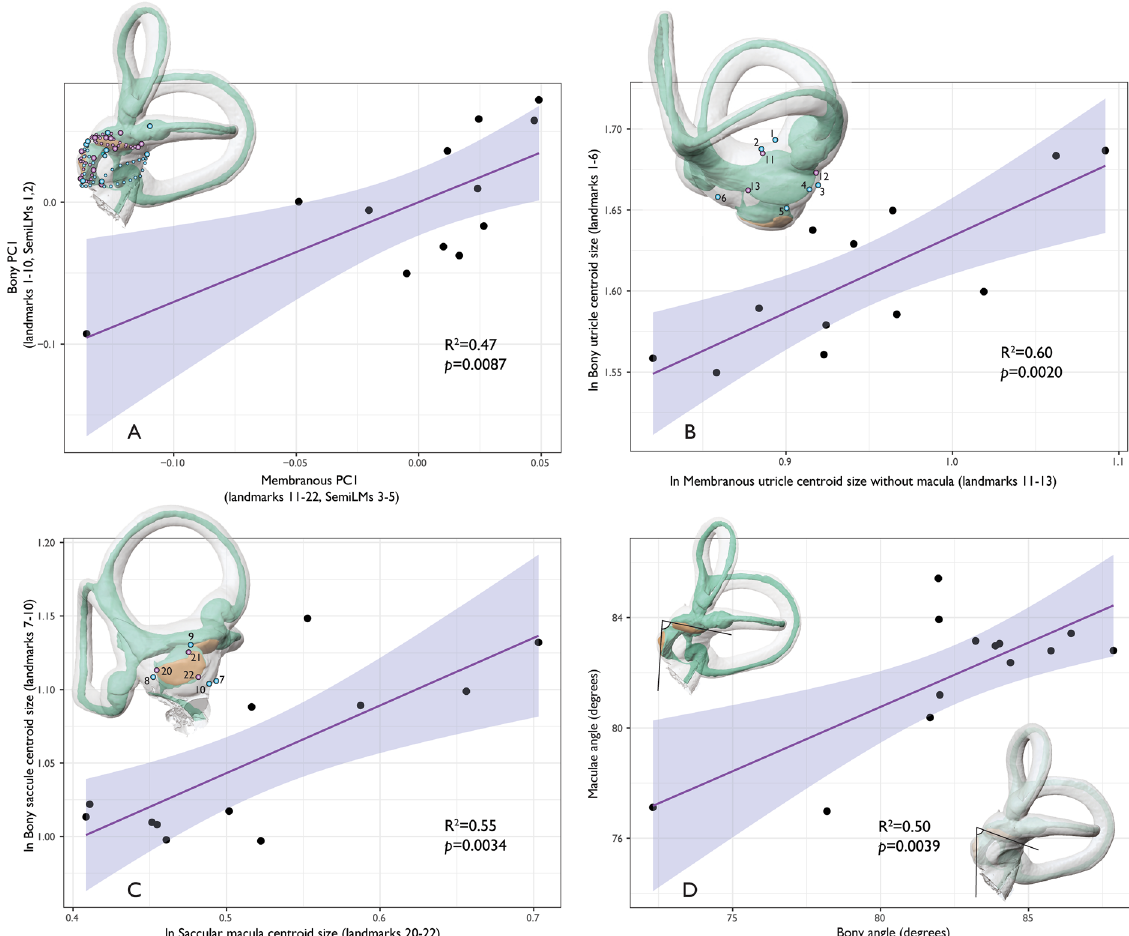
Figure 3. Bivariate plots of best fit OLS regressions of: ( A ) first principal components of the PCAs based on bony and membranous shape variation; ( B ) natural log-transformed centroid size of the bony utricle and membranous utricle; ( C ) natural log-transformed centroid size of the bony saccule and saccular macula; and ( D ) two sets of angles between: (1) planes fit to each macula (maculae angle); and (2) planes fit to a set of three bony landmarks surrounding the utricle (LMs 2, 4, and 6) and saccule (LMs 8–10) (bony angle). There are significant correlations between size and shape of the otolith organs and surrounding bone as well as between macula planes reconstructed from bony landmarks and from the maculae themselves. Purple: membranous landmarks; blue: bony Angles between approximated and actual maculae orientation were the lowest when using landmarks 2, 4, and 6 to estimate the plane derived from landmarks 17–19 on the utricular macula (Mean = 4.62° ± 1.75°, range = 1.26°–7.52°; Supplementary Fig. 6; see Supplementary Table 7 for a description of the angles used to estimate bony plane approximation of maculae). In every case, the plane of the utricular macula is tilted superi- orly relative to the bony angle in the lateral aspect. Differences for estimating saccular macula orientation were lowest between landmarks 8–10 and a selection of the spherical recess (Mean = 4.58° ± 2.67°, range = 1.32°–9.95°; Supplementary Fig. 6) or to landmarks 20–22 (Mean = 4.53° ± 2.20°, range = 1.23°–7.59°). In every case, the plane of the saccular macula is tilted laterally relative to the bony angle in the posterior aspect. Relative orientation of planes fit to otolith organ maculae (landmarks 17–19 and 20–22) significantly cor- relates with planes fit to surrounding bony structure (landmarks 2,4,6 and 8–10) ( p < 0.005; R 2 = 0.50) (Fig. 3D).